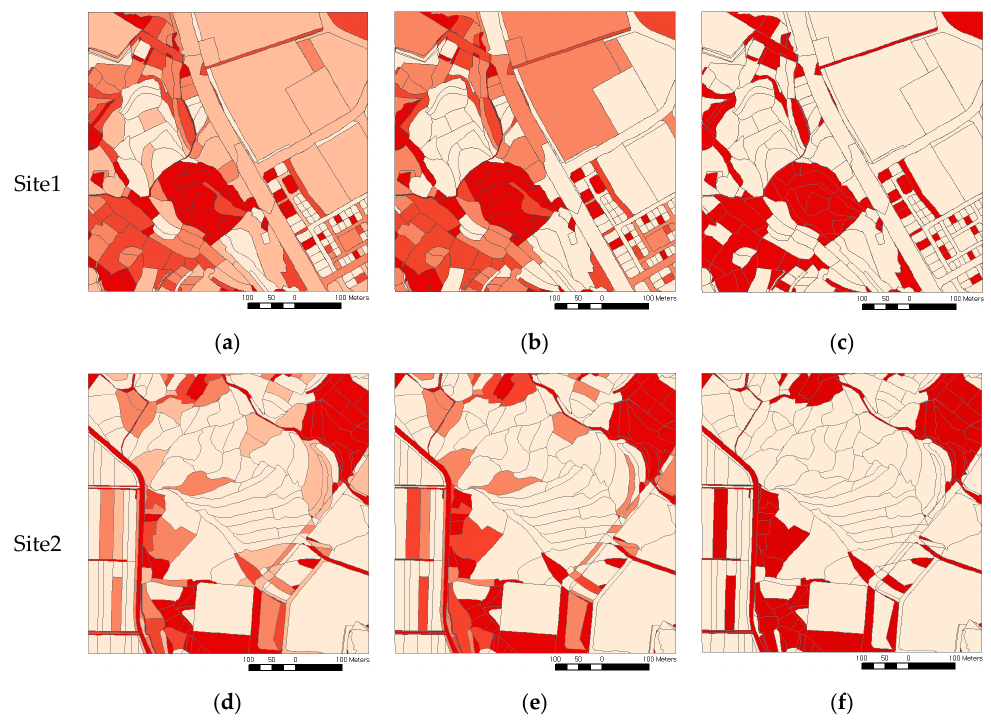
Figure 12. Visualization result of discrepancy ratios (the intensity of the red polygons directly relates to the discrepancy ratio): ( a ), ( d ) with five classes, ( b ), ( e ) with four classes, and ( c ), ( f ) with two classes.